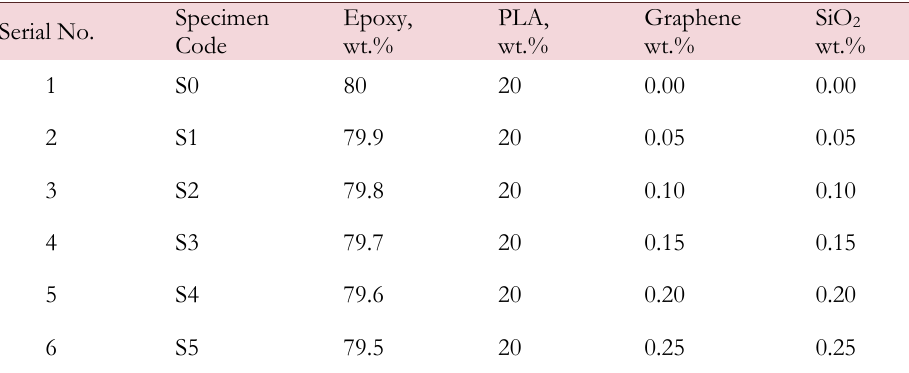
Table 3: Composition of the pristine epoxy-PLA and